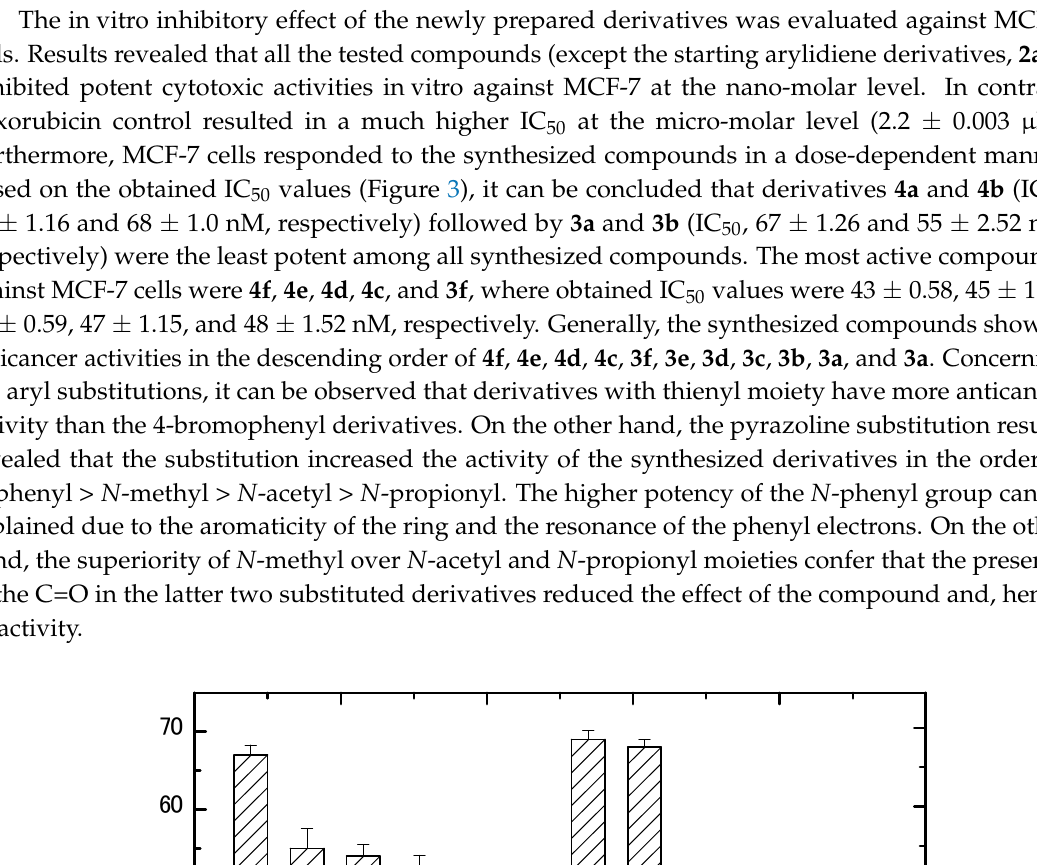
Figure 2. Synthetic route for compounds 2a , b , 3a – f , and 4a – f .